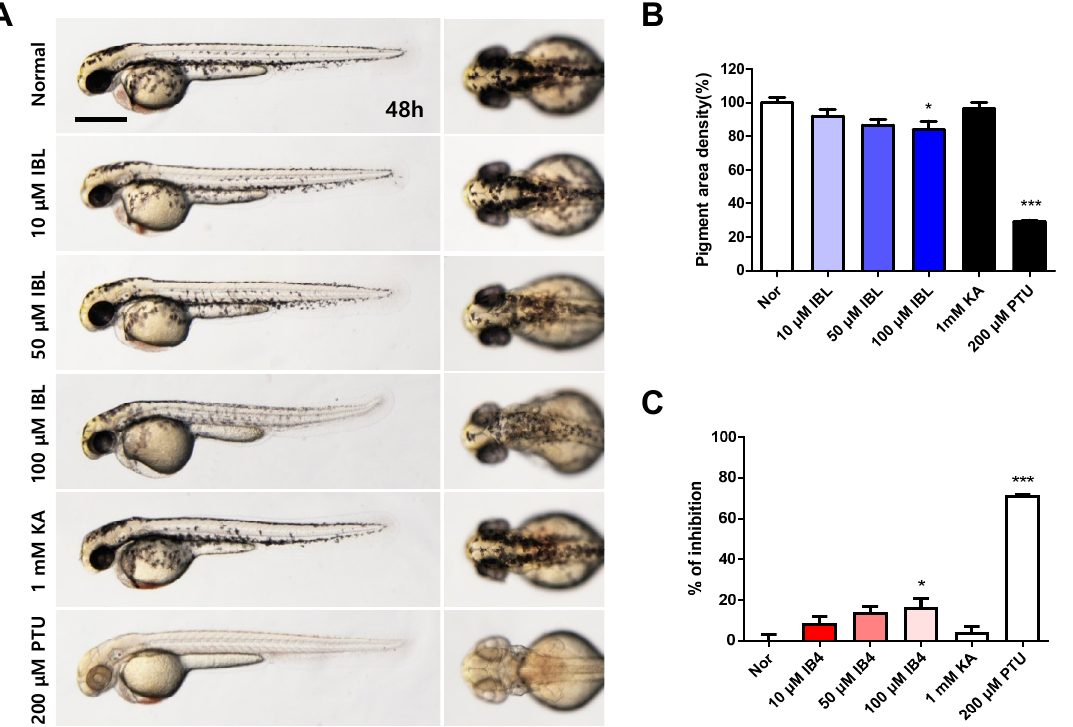
Figure 8. Effect of IBL on melanin production in developing zebrafish embryos. Zebrafish embryos were treated with IBL (10, 50, or 100 µM), kojic acid (KA, 1 mM), phenylthiourea (PTU, 200 µM), or 0.1% (v/v) DMSO (Normal). ( A ) Pigmentation in the embryos was observed under a stereomicroscope (lateral and dorsal views) at 48 hpf. Scale bar: 0.5 mm. ( B , C ) The pigmented area density and inhibition rate was normalized to that of the control embryos using the Image J software ( n = 8). The values are represented as means ± SEM from three independent experiments. * p < 0.05 vs. Control, *** p < 0.001 vs. Control. 0.1% A DMSO-treated embryo was set as the normal.